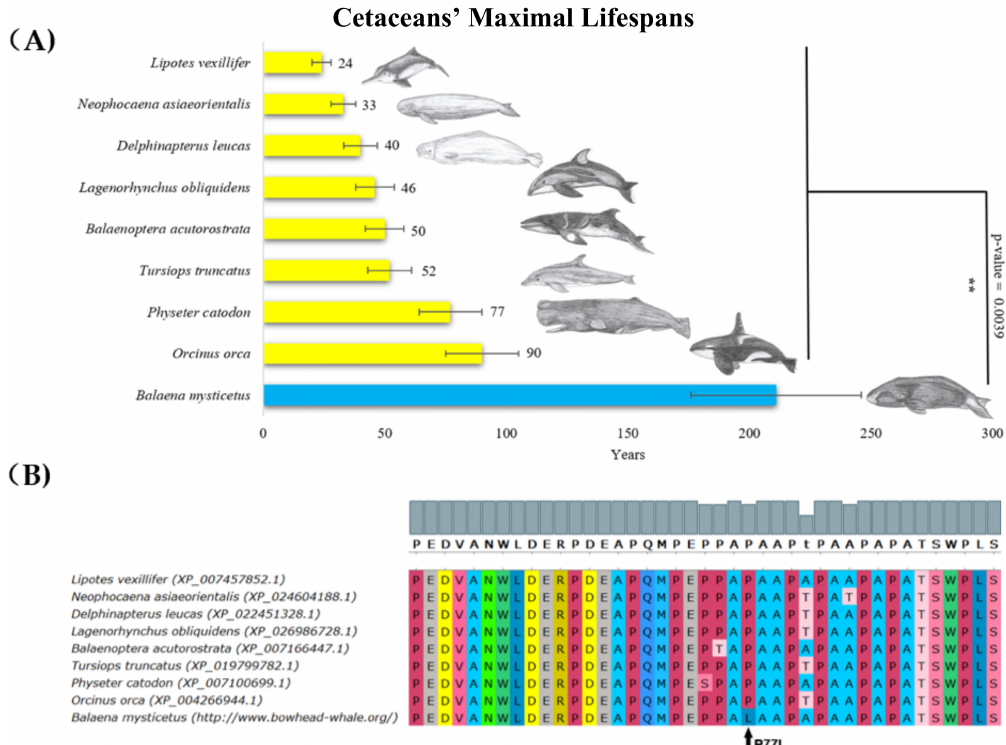
Figure 1. Lifespan of species in the Cetacea order and the corresponding p53 sequence changes. ( A ) Comparison of cetaceans’ maximal lifespans in years. The bowhead whale’s ( Baleana mysticetus ’s) maximal lifespan was more than twice the maximal lifespan of the rest of Cetacea (Wilcoxon one-sided signed-rank test was used, ** p -value < 0.01). ( B ) Multiple sequence protein alignments of p53 proline-rich region, performed in MUSCLE with default parameters [47], colors in “UGENE”